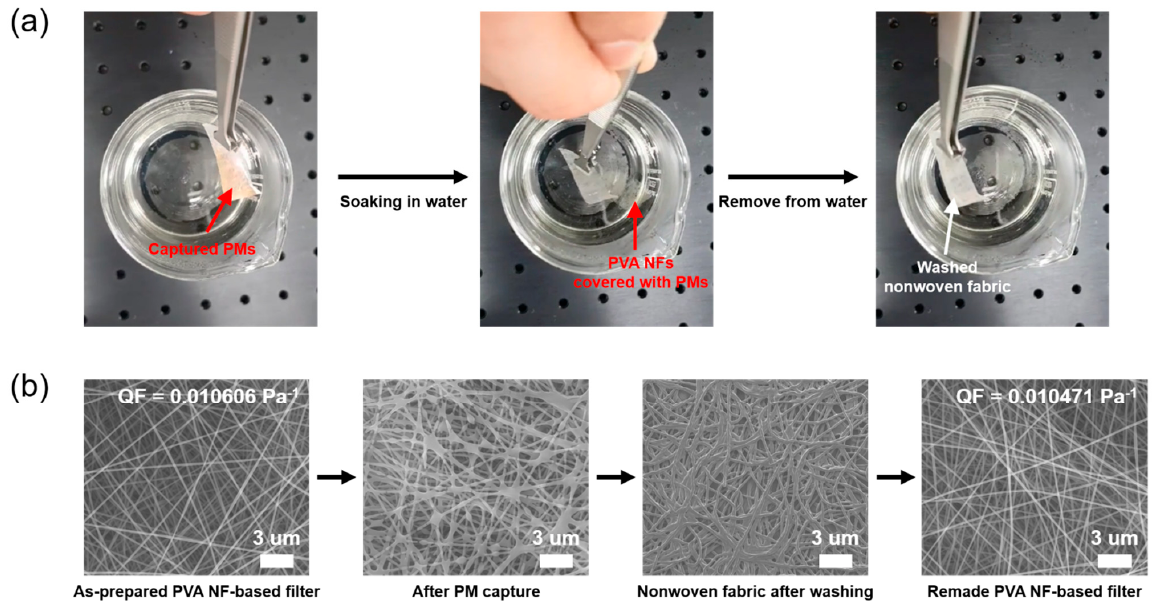
Figure 4. ( a ) Selective removal of PM − captured poly(vinyl alcohol) nanofiber (PVA NF) layer by immersion in water; ( b ) surface field-emission scanning electron microscopy (FE-SEM) images of the PVA NF − based filters during recycling.